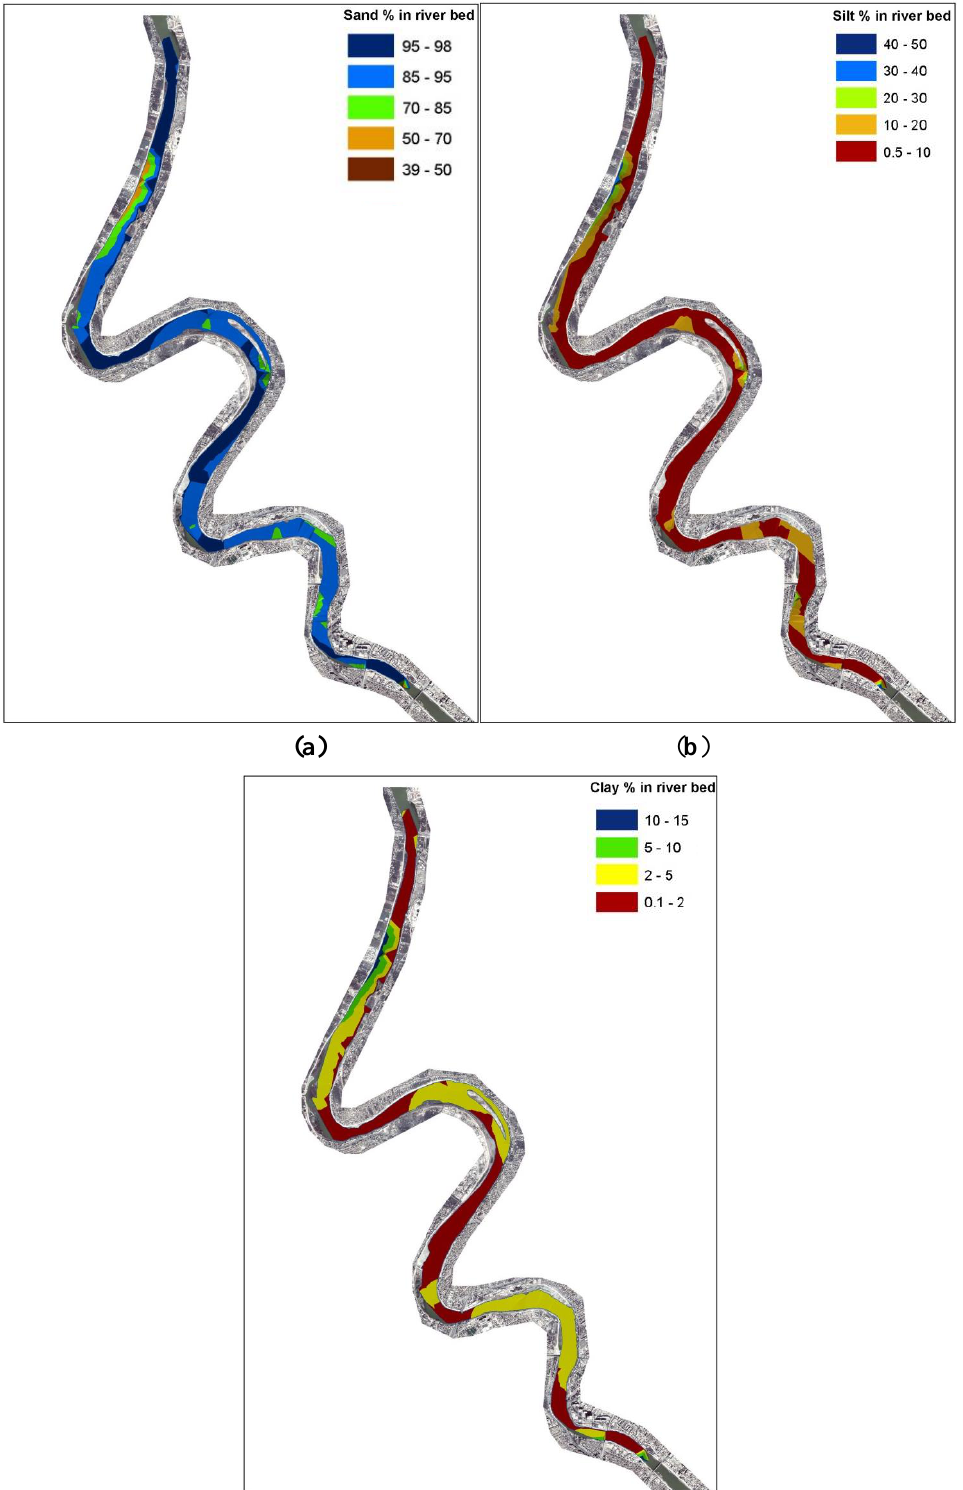
Figure 10. ( a ) Distribution of sand; ( b ) Distribution of silt; ( c ) Distribution of clay on the bed of Tigris River at Baghdad.